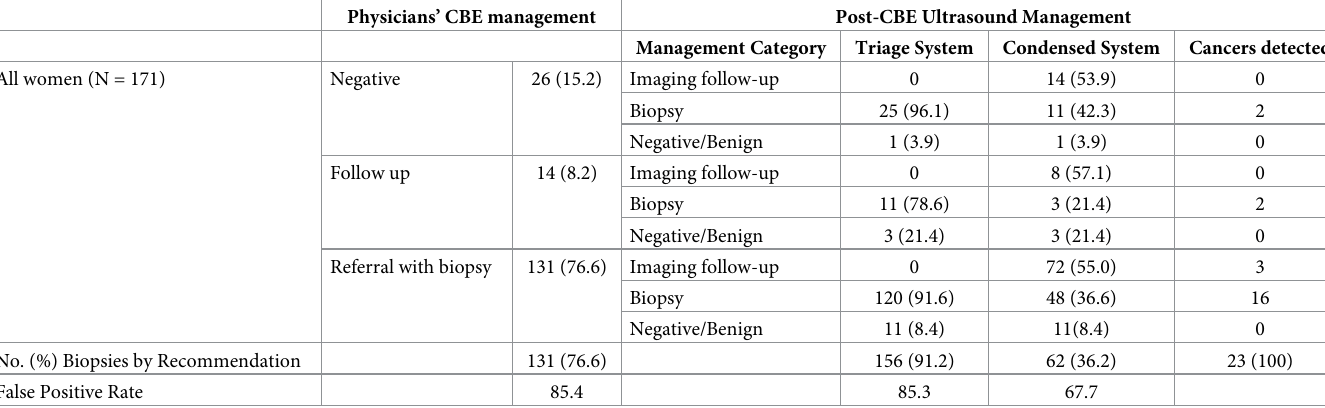
Table 3. Clinical management changes before and after breast ultrasound for all women.